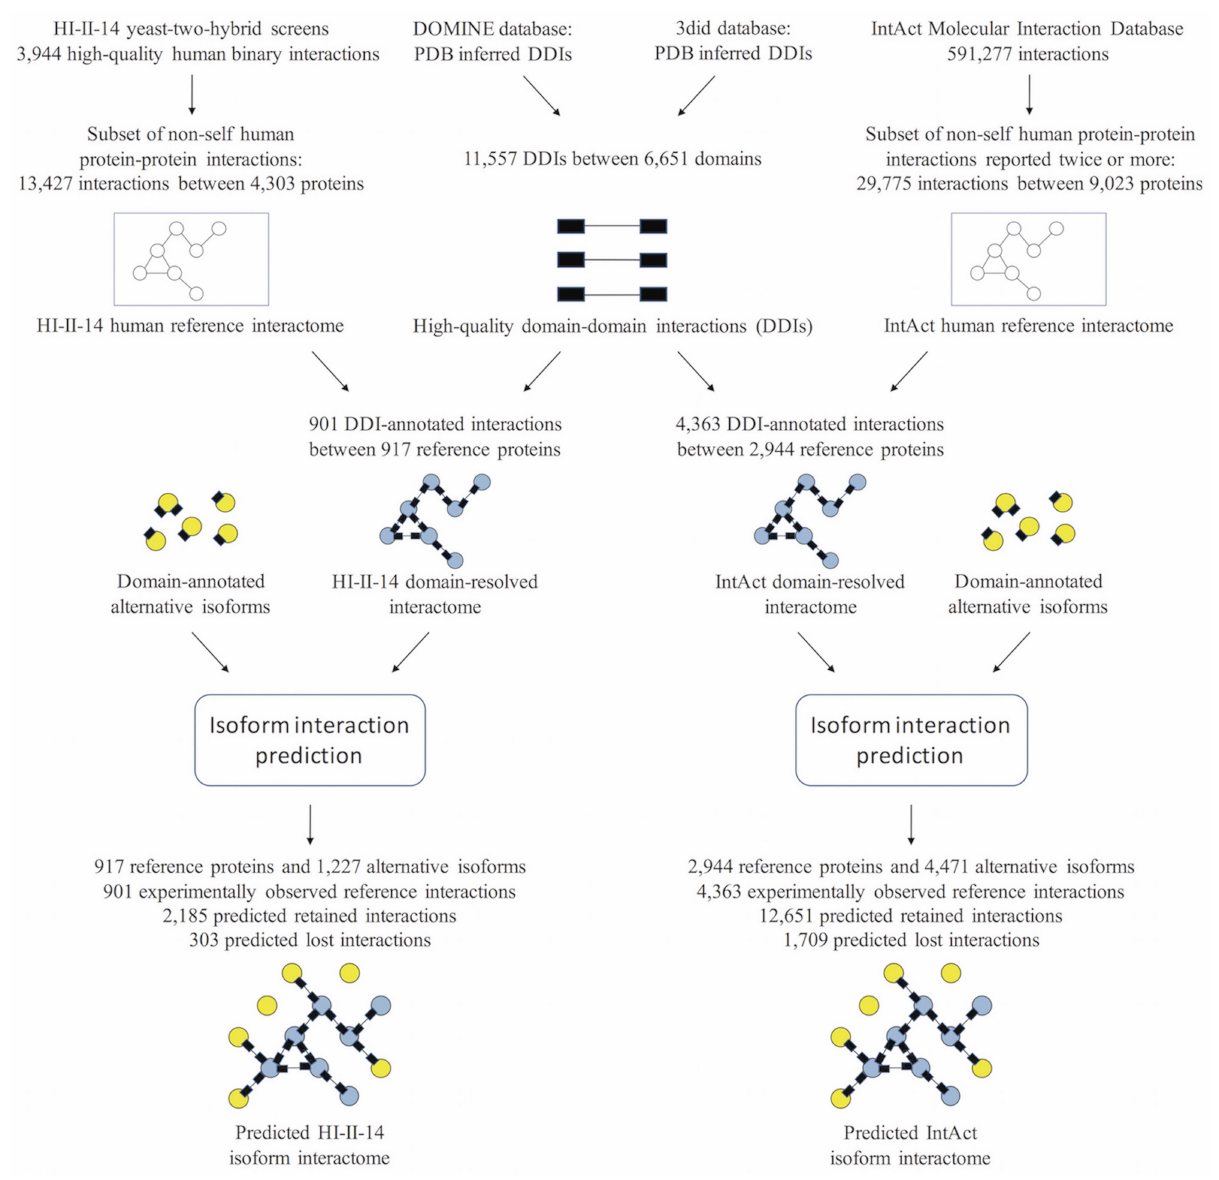
Fig 1. Computational pipeline for the prediction of the human isoform interactome. Domain-domaininteractions are mapped onto two human reference interactomes, HI-II-14 [13] and IntAct [11]. The resultingdomain-resolved reference interactomes are then used to predict interactionsfor the alternativeisoforms of proteins in these interactomes, resultingin two predicted isoform interactomes.